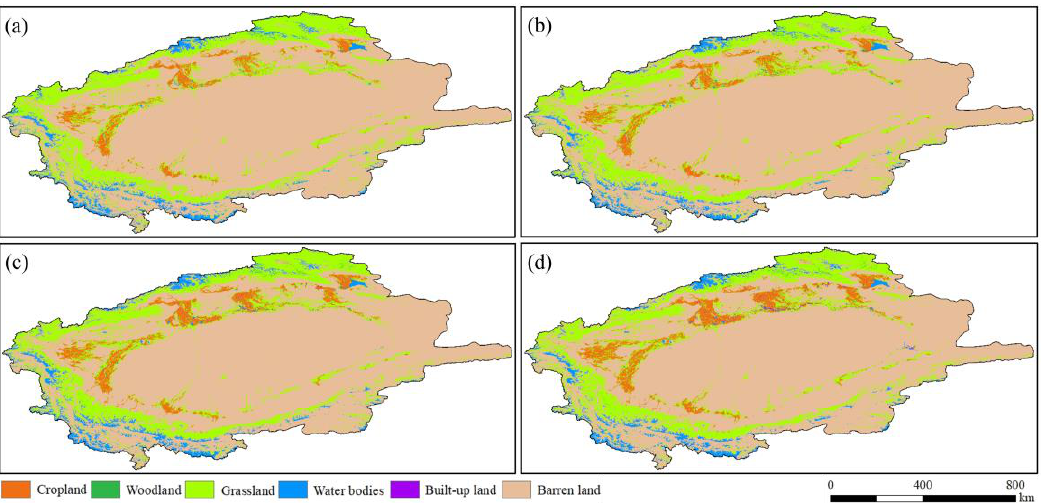
Figure 2. Land uses in the Tarim River Basin from 1990 to 2020. ( a ): 1990, ( b ): 2000, ( c ): 2010, and ( d ): 2020.